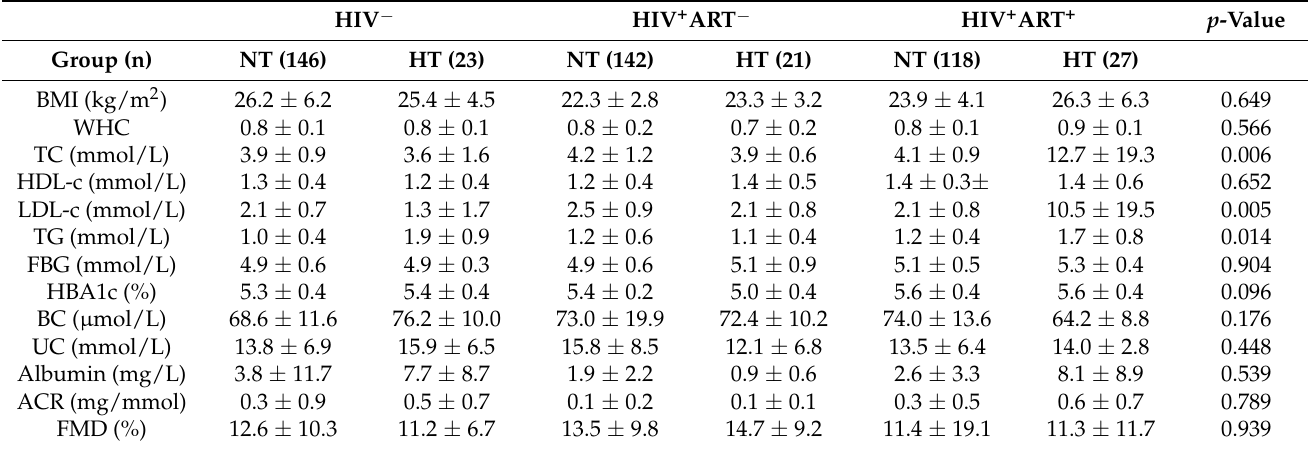
Table 3. Effect of ART and hypertension on cardiovascular risk